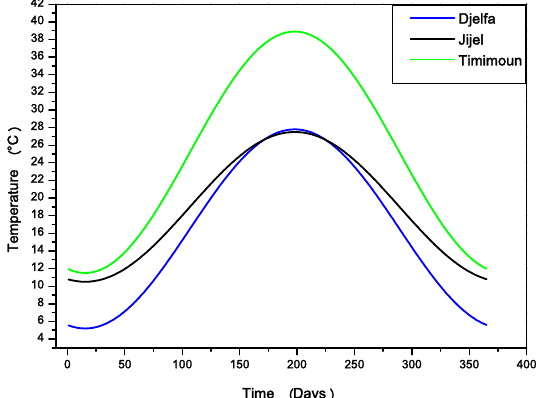
Figure 5. Annual variation of ambient temperature in three different